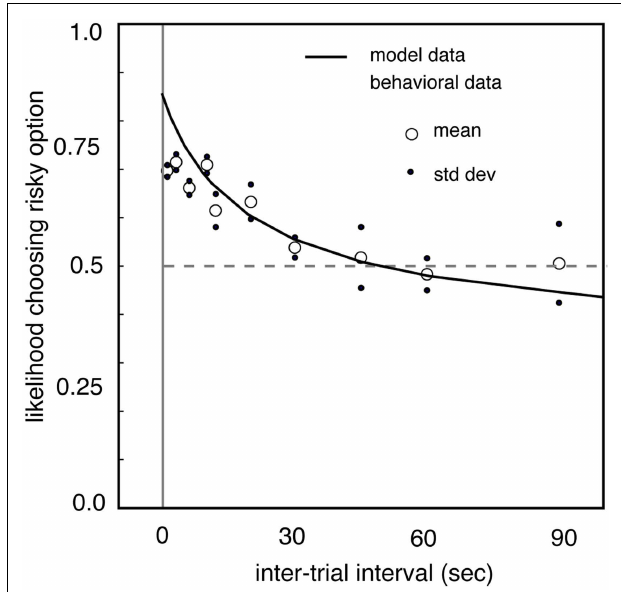
FIGURE 3 | Risk-seekingness of two macaques as a function of delay between trials. Our observations indicate that inter-trial interval has a large effect on risk preferences. As delay between trials increases (horizontal axis), propensity to choose risky option (vertical axis) declines.When delay between trials reaches 90s, monkeys are risk-neutral.These observations highlight the strong effect that rapid serial presentation of gambles has on promoting risk-seeking preferences. Adapted from (Hayden and Platt,